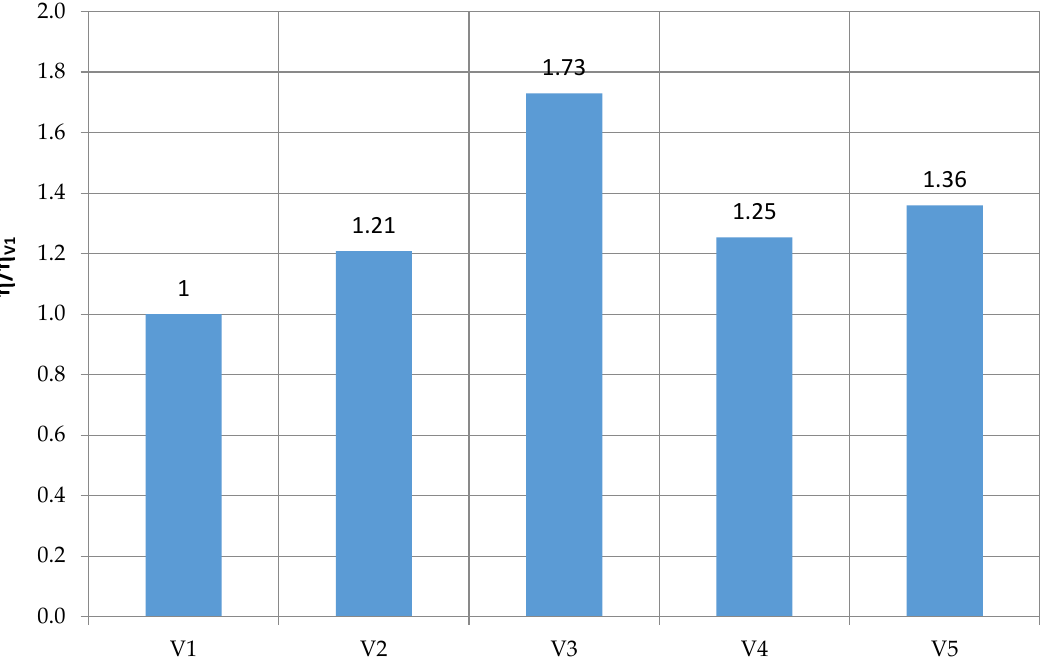
Energies 2019 , 12 , x FOR PEER REVIEW Figure 10. The influence of the cycle structure on its e ffi ciency as compared to variant 1 for hydrogen. Figure 10. The influence of the cycle structure on its efficiency as compared to variant 1 for hydrogen.